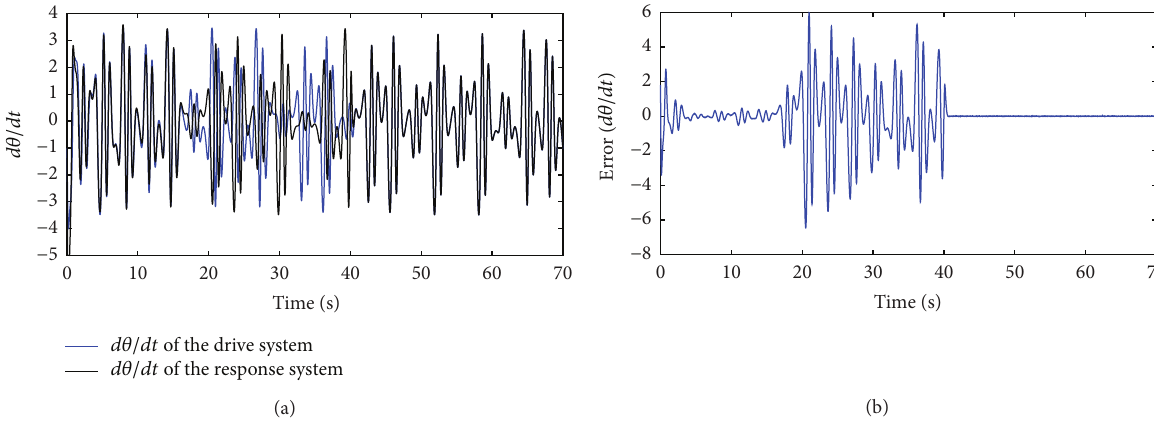
̇𝜃 of drive and response systems, (b)